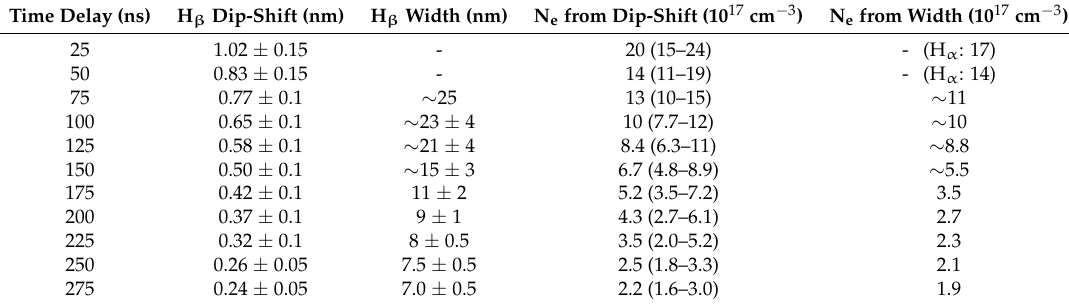
Table A1. Average H β central dip-shifts, widths, and electron densities, N e , from dip-shifts and widths for selected time delays of optical breakdown in 0.76 × 10 5 Pa hydrogen gas